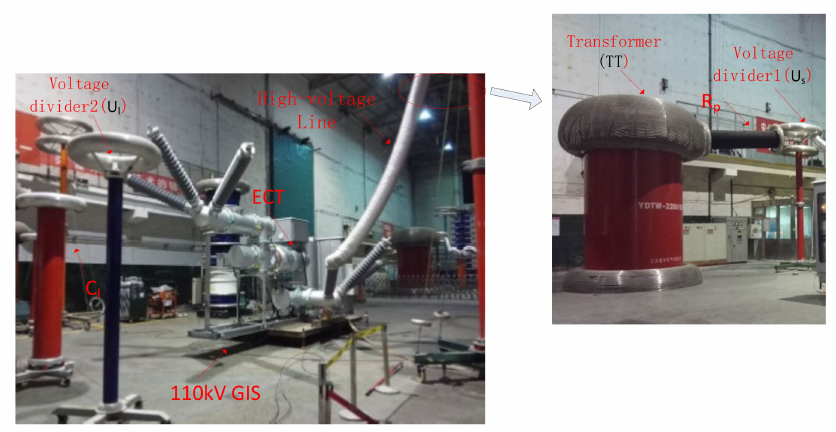
Figure 19. Experimental setup of the ECT (Test duty